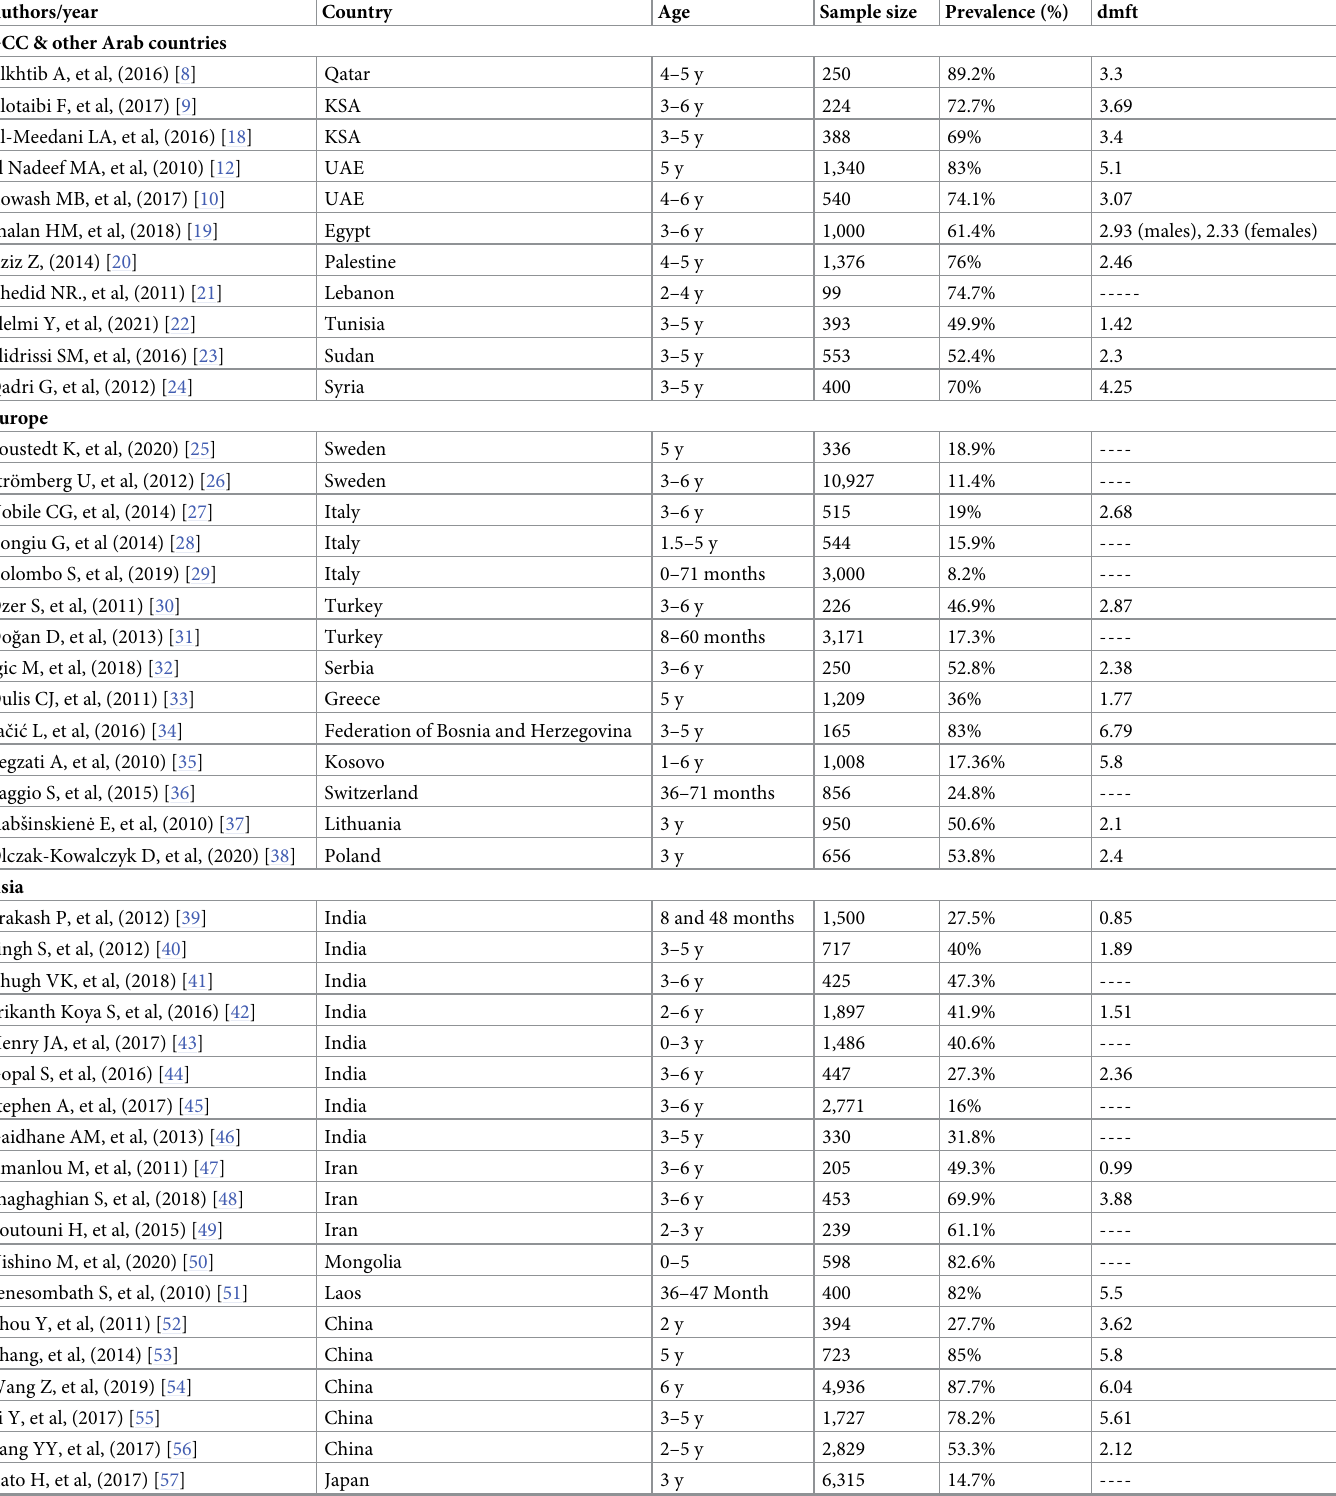
Table 2. Included studies reporting on dental caries prevalence and experience in primary teeth of children 0–6